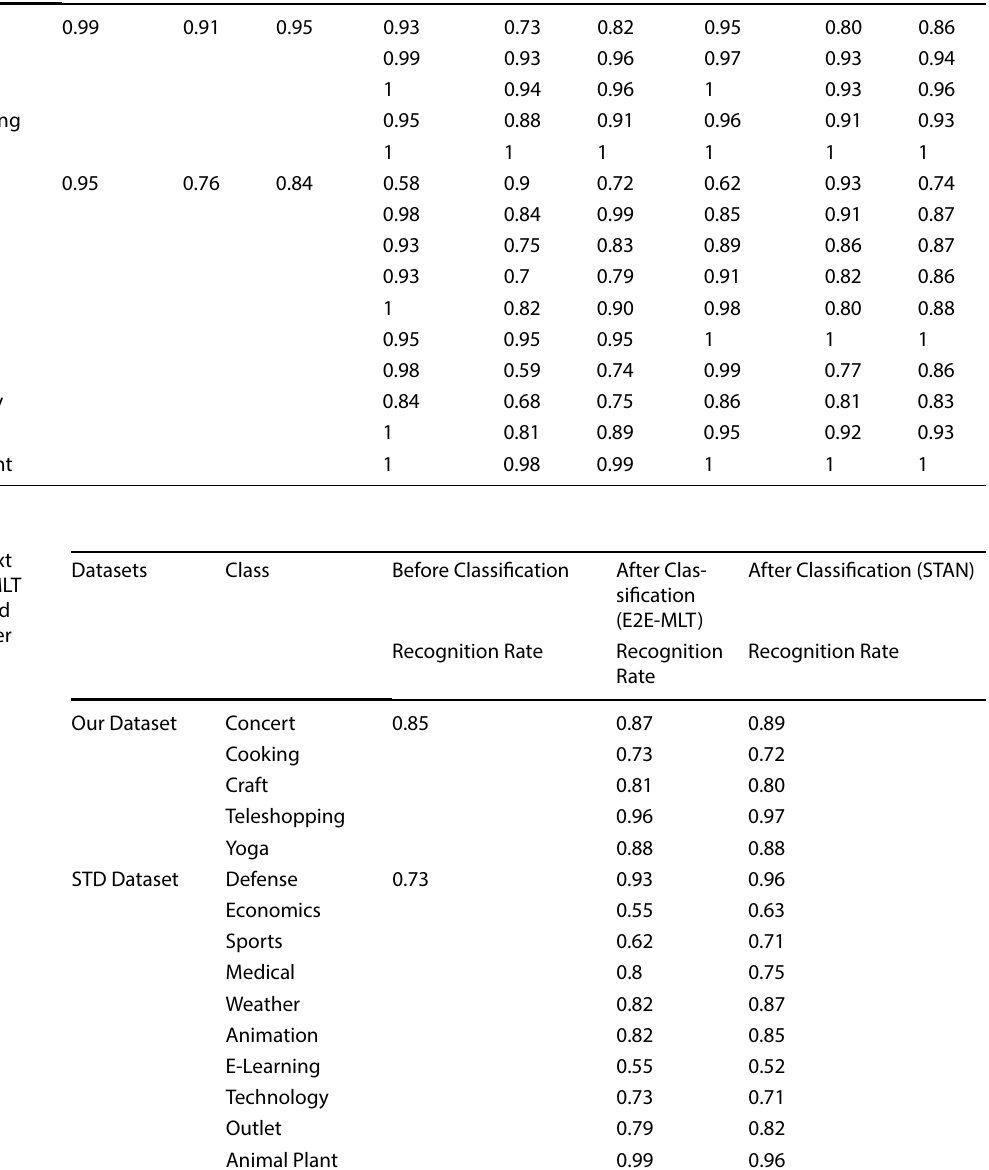
Table 10 Performance of text detection methods (EAST and TextMountain) before and after classification on our and STD datasets Datasets